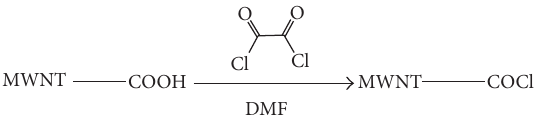
F 3: Preparation of